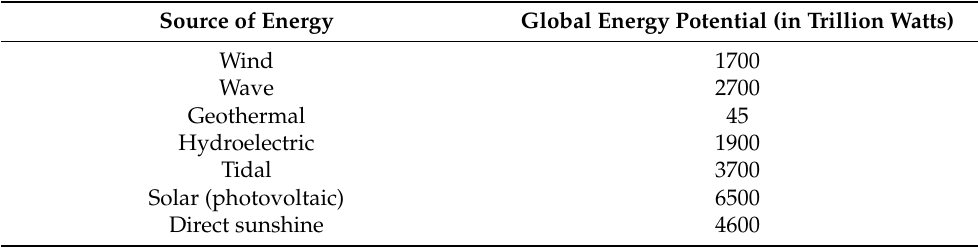
Table 1. Global availability of renewable energy sources. Source of